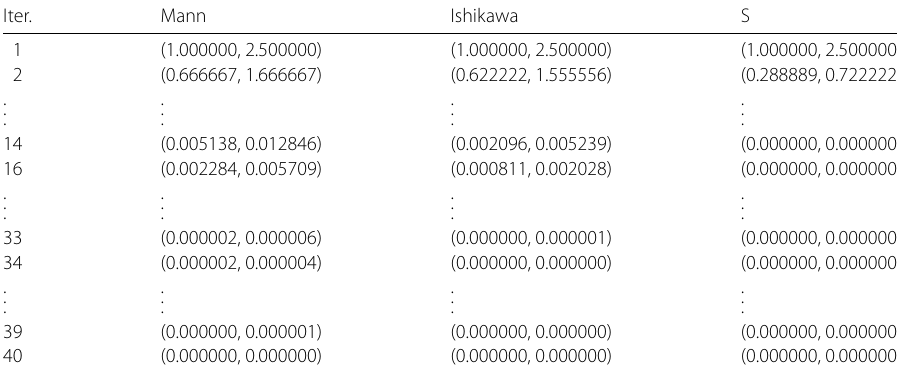
Table 1 Computational table of different iteration processes Iter.